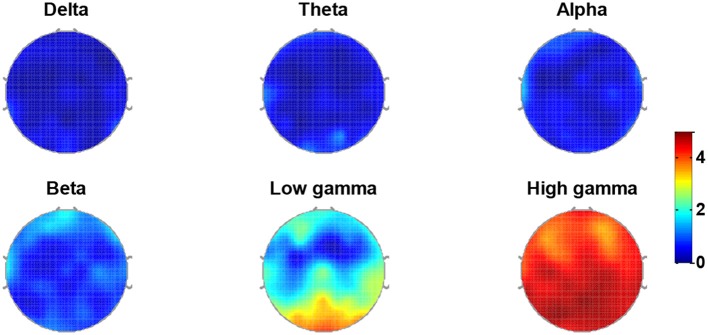
Topographic mapping of the quantified feature contributions averaged across 17 subjects for delta, theta, alpha, beta, low gamma, and high gamma bands.